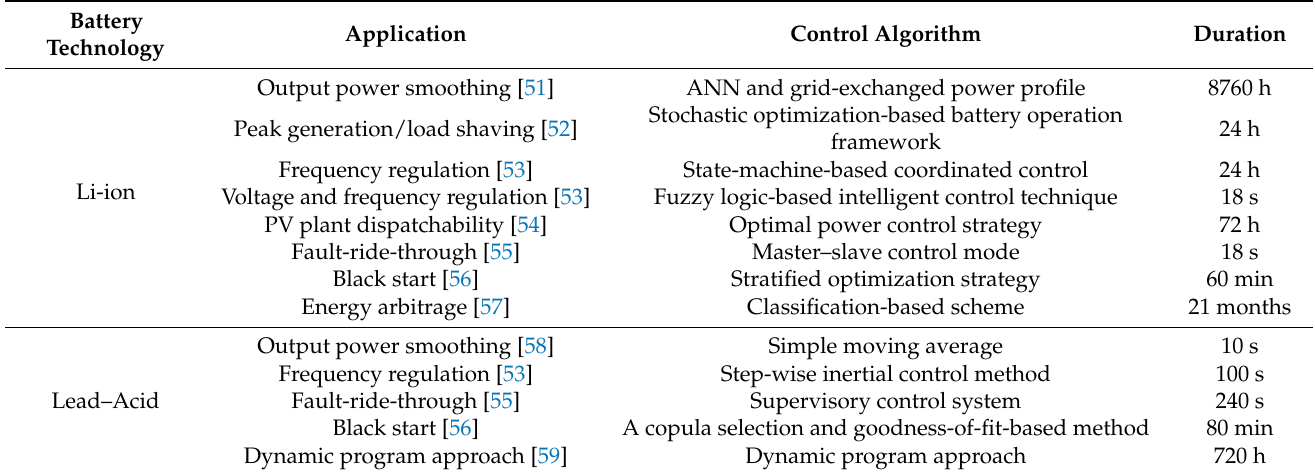
Table 4. BESS control algorithms and application.